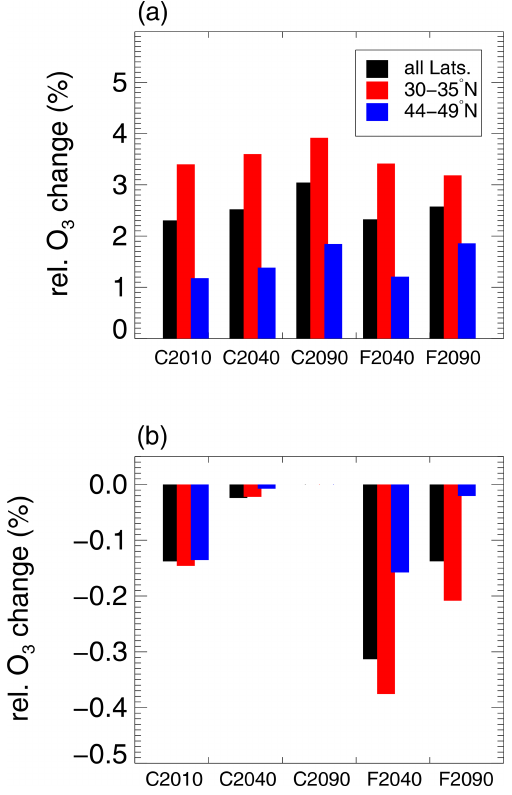
Figure 9. Relative chemical ozone change in the mixing layer deter- mined from the difference between initial and final ozone in the 10- day CLaMS box-model simulations (no mixing between air masses) in all considered cases (see Table 1). The relative ozone change is shown (a) considering the entire latitude region above central North America (black bars) as well as only considering the subtropical (30–35 ◦ N, red bars) or extratropical (44-49 ◦ N, blue bars) latitude region. Further, the ozone change from air masses in which chlorine activation can occur normalized by the total initial ozone from all air masses in the simulated mixing layer is shown (b)